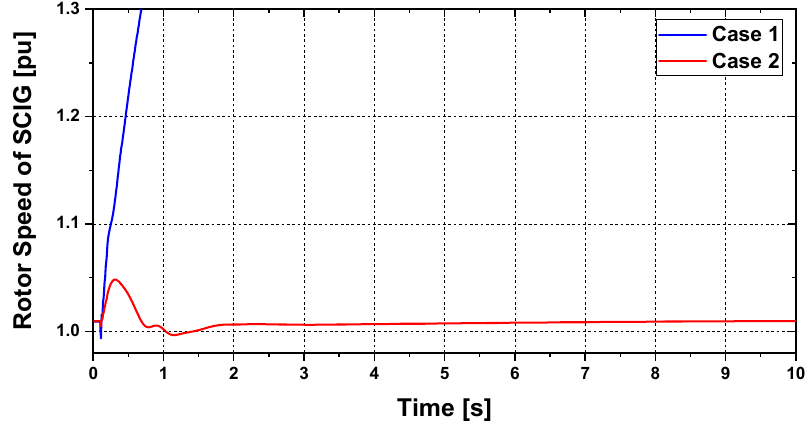
Figure 14. Rotor speed response of SCIG.